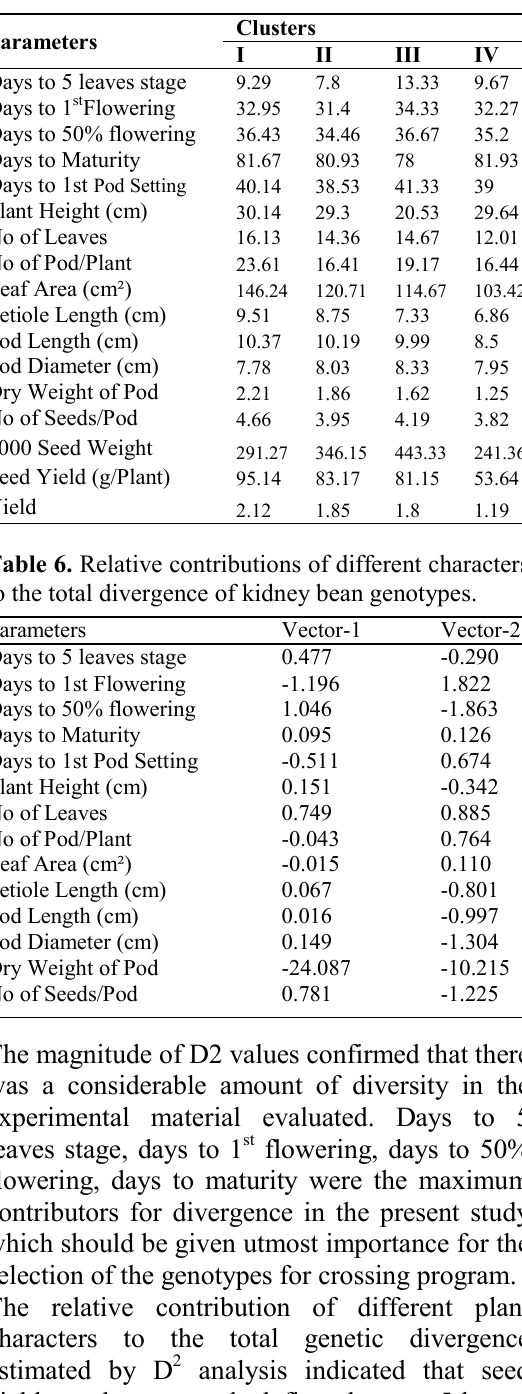
Table 5. Cluster mean values of different characters of kidney bean genotypes.